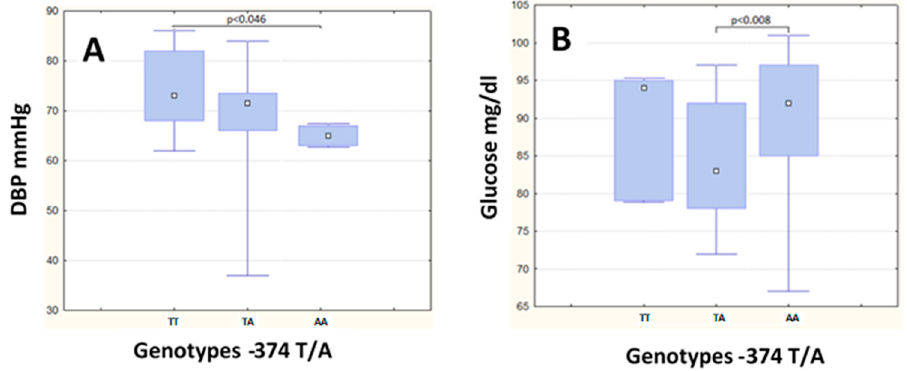
Figure 1. Diastolic blood pressure (DBP) and glucose levels in the − 374 T/A SNP in non-MS group. Differences in ( A ) Diastolic Blood Pressure and ( B ) Glucose levels among genotypes of the − 374 T/A SNP in the non-MS group.